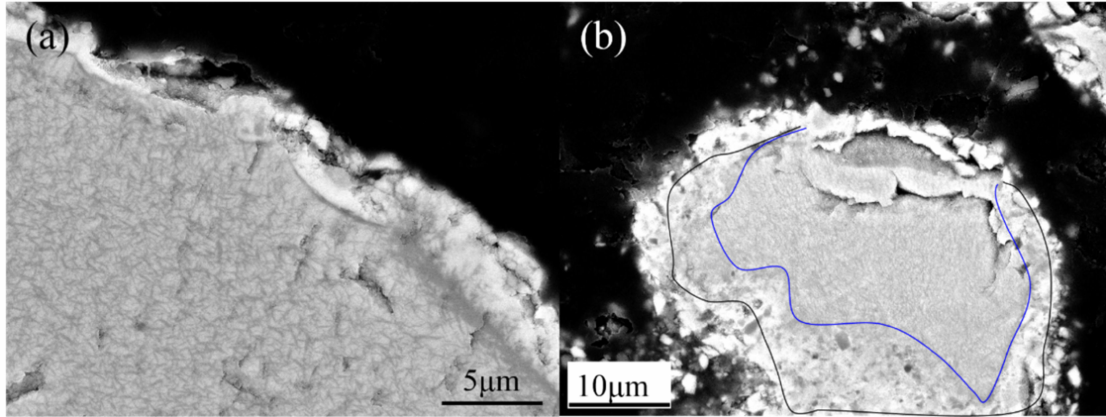
Figure 8. Microstructures of ilmenites with different diameters at 800 ◦ C for 60 min for ( a ) A0 64.5 µ m and ( b ) A1 19.8 µ